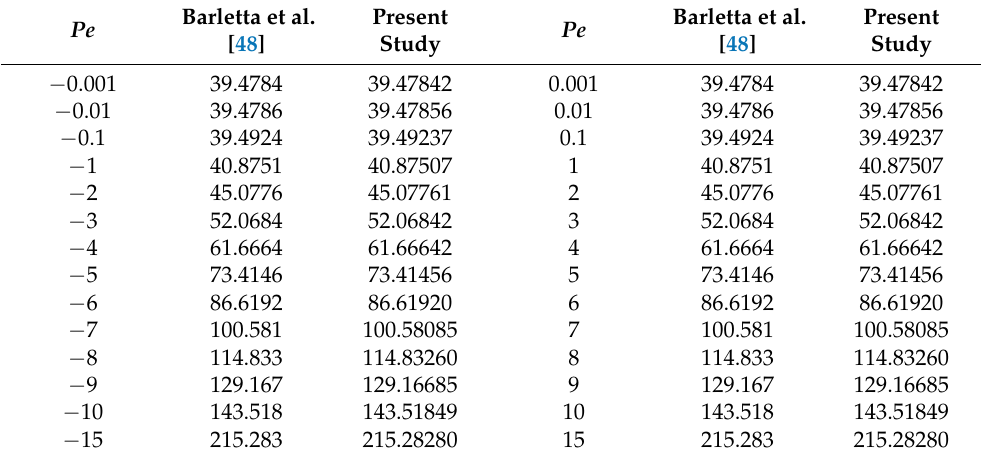
Table 2. Critical Rayleigh number values for Q = 0; Ta = 0 and Da = 0 compared with [48].